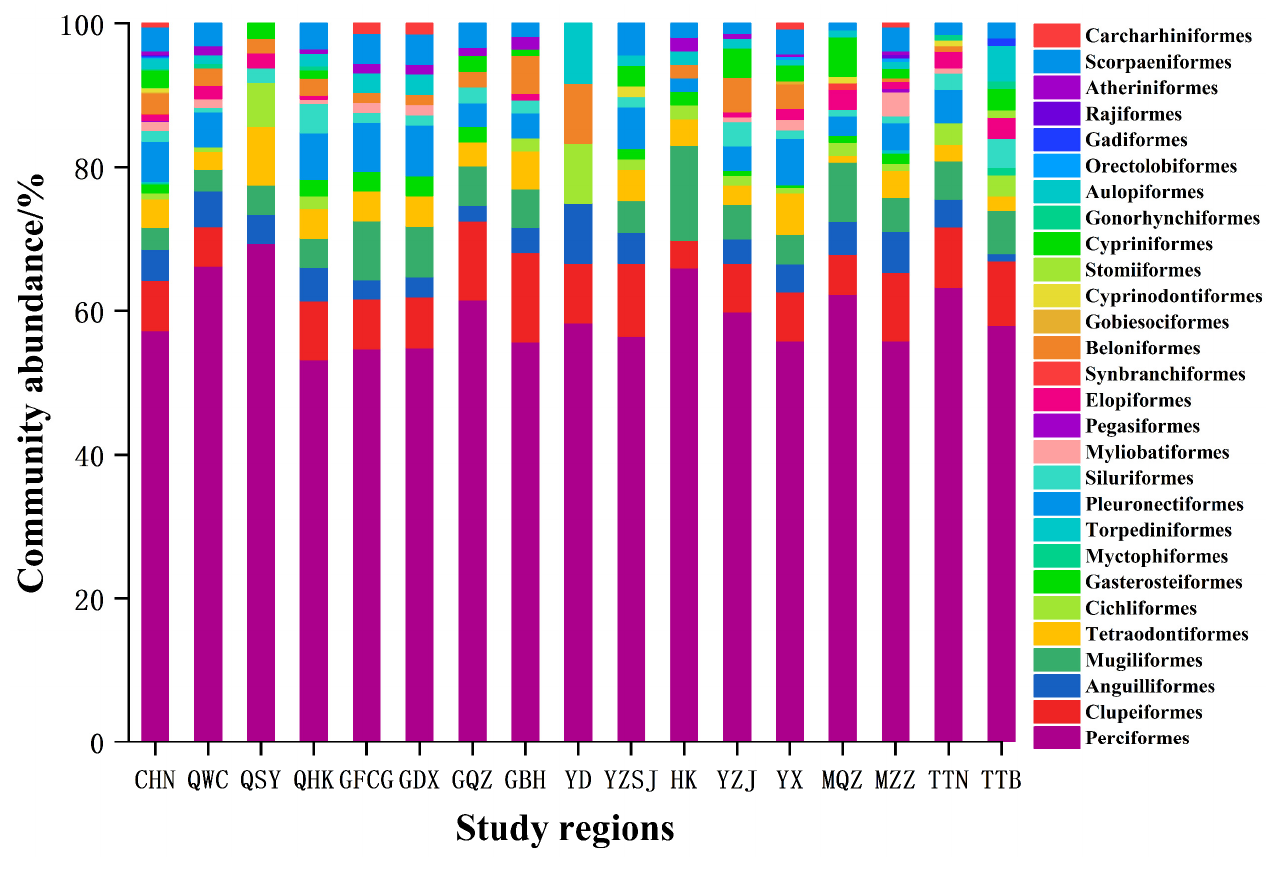
Figure 2. Relative abundance of fish community composition at the order levels across different mangrove regions. CHN: CHINA; QWC: Wenchang, Hainan; QSY: Sanya, Hainan; QHK: Haikou, Hainan; GFCG: Fangchenggang, Guangxi; GDX: Dongxing, Guangxi; GQZ: Qinzhou, Guangxi; GBH: Beihai, Guangxi; YD: Eastern Guangdong; YZSJ: Pearl River Delta; HK: Hong Kong; YX: Western Guangdong; YZJ: Zhanjiang, Guangdong; MQZ: Quanzhou, Fujian; MZZ: Zhangzhou, Fujian; TTN: Tainan, Taiwan; TTB: Taipei, Taiwan.